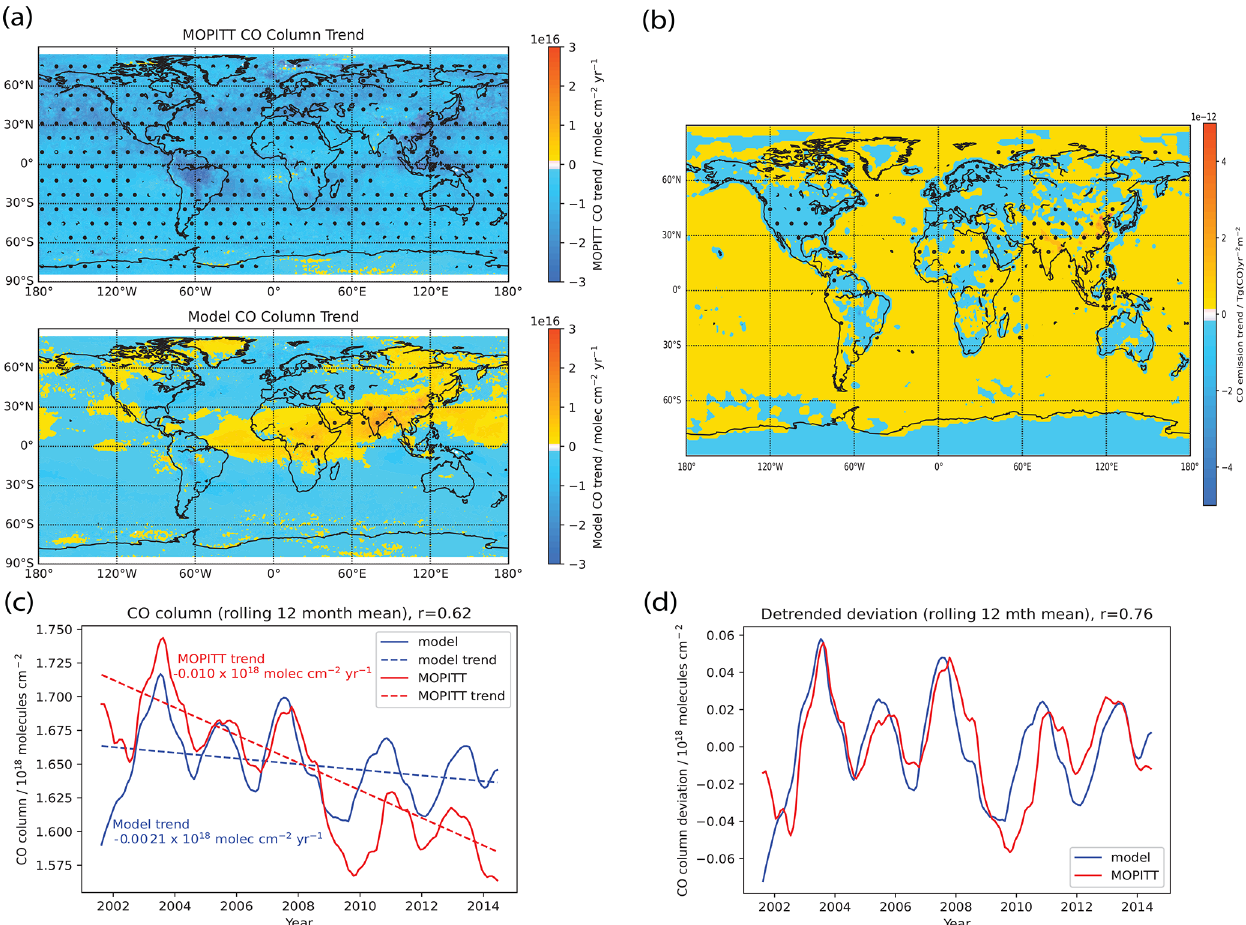
Figure 11. (a) Model comparison of annual mean CO column trends with MOPITT observations over the 2001–2014 period, (b) CO emission trends over the 2001–2014 period, (c) model comparison of area-weighted global (60 ◦ S–60 ◦ N) mean 12-month rolling mean CO columns with MOPITT observations over the 2001–2014 period and (d) model comparison of area-weighted global (60 ◦ S–60 ◦ N) 12-month rolling mean detrended CO columns with MOPITT observations over the 2001–2014 period. Trends and stippling in panels (a) and (b) are as per Fig. 3. For panel (c) , the dotted lines represent the linear trend line as calculated using the Theil–Sen method. The MOPITT CO column generally sees significant negative trends throughout the spatial domain. However, the modeled CO columns show mixed trends which mirror the CO emission trends as seen in panel (b) , especially the increasing trend over China and South Asia, and are in poor agreement with trends derived from MOPITT. We can also see from panel (c) that the model underestimates the negative trend seen in MOPITT. However, from panels (c) and (d) , we see that the model captures the MOPITT IAV well, with Pearson correlation coefficient of r = 0 . 62 and r = 0 . 76 for the raw and detrended time series,